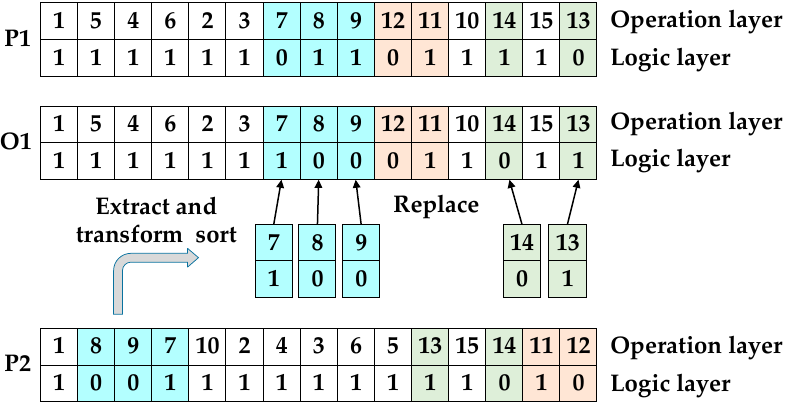
Figure 9. An example of crossover for logic layer.